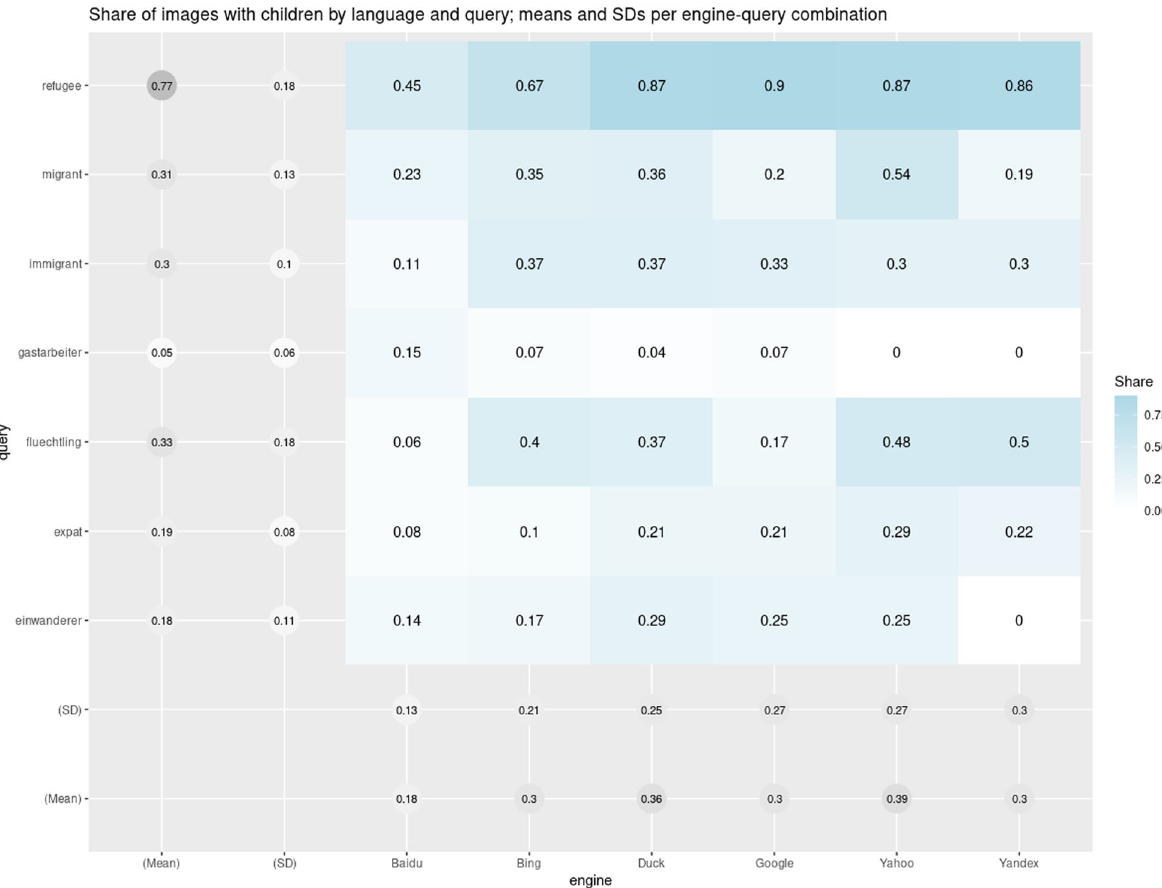
Fig. 5 Share of images depicting children by engine and query. Share of images with children by search engine and